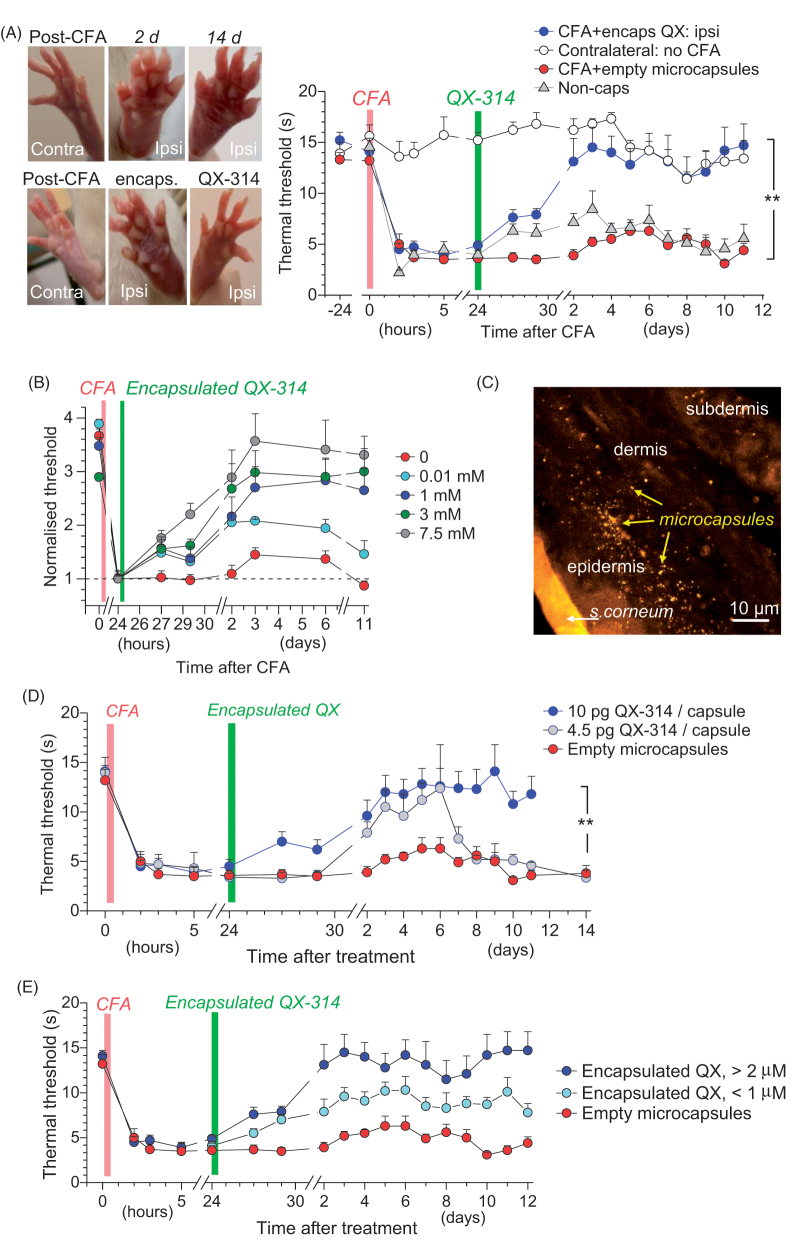
The anti-nociceptive effect of encapsulated QX-314 in a persistent pain model in rodents. (A) Image panels, examples of rat hind paw following injection of CFA with no treatment (top row) and with encapsulated QX-314 (∼3 mM; bottom row) at different time points, as indicated; ipsi, ipsilateral, inflammatory side; contra: contralateral, non-inflamed, side. Graph, time course of the thermal nociceptive threshold in control (contralateral, n = 5 rats) and CFA-inflamed animals injected with empty microcapsules (n = 5) or encapsulated QX-314 (∼3 mM, n = 6) or non-capsulated QX-314 (100 mM, n = 5), as indicated. (B) Time course of the thermal nociceptive threshold (normalized to that at the treatment onset, which is 24 h post-CFA), for different dosage of encapsulated QX-314, as indicated: 10 µM (n = 6 rats), 1 mM (n = 8), 3 mM (n = 6), and 7.5 mM (n = 7). (C) Fluorescent image (FITC fluorescence, transverse skin tissue section) displaying the epidermal–dermal area (the rat hind paw) with scattered microcapsules on Day 1 after microcapsule injection. (D) Time course of inflammatory hypersensitivity in rats with persistent peripheral inflammation following treatment with different amounts of QX-314 per capsule, as indicated (animals received the same overall dose of QX-314, 1 mM): 4.5 pg (n = 6 rats), 10 pg (n = 8) and 0 pg (empty, n = 5). (E) Time course of inflammatory hypersensitivity with QX-314 in microcapsules of different sizes (animals received the same overall dose of encapsulated QX-314, 3 mM): 2 µm diameter (n = 6 rats), 1 µm (n = 9) and empty (varied size, n = 5). Data are shown as mean ± SEM. **p < .01 (one-way ANOVA with Bonferroni post hoc test for encapsulated QX-314 compared with empty microcapsules).